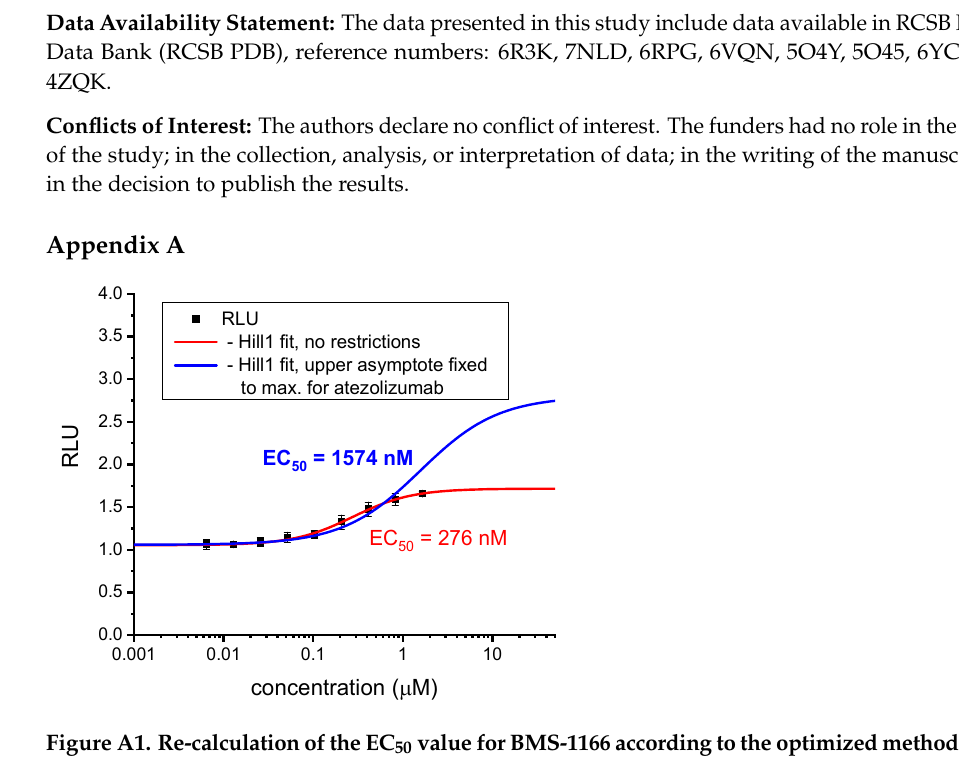
Figure A1. Re-calculation of the EC 50 value for BMS-1166 according to the optimized method. Initial calculations for the biphenyl BMS molecules were carried out without any restrictions to the fitting parameters [5]. With time, we learned that this may lead to depreciated EC 50 values, since the upper plateau of the experimental points, and thus the upper asymptote of the fitted curve may be lowered by unspecific effects such as cell toxicity. Therefore, in subsequent analyses, we fixed the upper asymptote of curve fittings at a value observed for therapeutic anti-PD-L1 antibody, either atezolizumab or durvalumab. These values were considered maximal effector Jurkat T cells activation levels achievable in the assay. As shown in this figure, such an analysis leads to determining higher EC 50 values, which in our opinion are more relevant and better reflect the real bioactivity in the ICB assay.